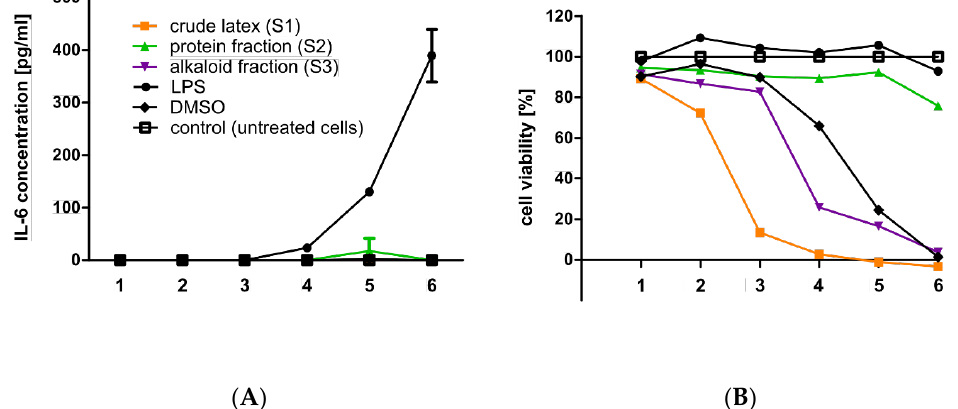
Figure 12. ( A ) Effect of crude C. majus latex (S1), protein fraction (S2), and alkaloid-rich fraction (S3) on the secretion of interleukin 6 (IL-6) by RAW 264.7 cells. Consecutive numbers (1 – 6) on the x axis correspond to different protein concentrations in the crude latex (S1) and protein fraction (S2) applied on cells: 1 = 1.6 × 10 −4 mg/mL, 2 = 4.0 × 10 −4 mg/mL, 3 = 1.6 × 10 −3 mg/mL, 4 = 8.0 × 10 −3 mg/mL, 5 = 1.6 × 10 −2 mg/mL, 6 = 8.0 × 10 −2 mg/mL. In the case of alkaloid-rich fraction (S3), consecutive numbers (1 – 6) correspond to its different dilutions: 1 = 2 × 10 −4 , 2 = 5 × 10 −4 , 3 = 2 × 10 −3 , 4 = 10 −2 , 5 = 2 × 10 −2 , 6 = 10 −1 . Cells treated with crude latex and its fractions in all dilution ranges tested (10 −1 – 2 × 10 −4 ) did not secrete IL-6 in detectable amounts. LPS-treated cells (100 ng/µL) (positive control) secreted IL-6 at a level of 424.7 pg /μL. ( B ) Simultaneous analysis of the effect of crude C. majus latex, alkaloid-rich fraction, and protein fraction on RAW 264.7 cell viability. Among the tested samples, the strongest cytotoxicity was shown for the crude latex and the alkaloid-rich fraction in the range of 8.0 × 10 −3 – 8.0 × 10 −2 mg/mL (numbers 4 – 6). The protein fraction showed the lowest toxicity to RAW 264.7 cells in all analyzed concentrations.